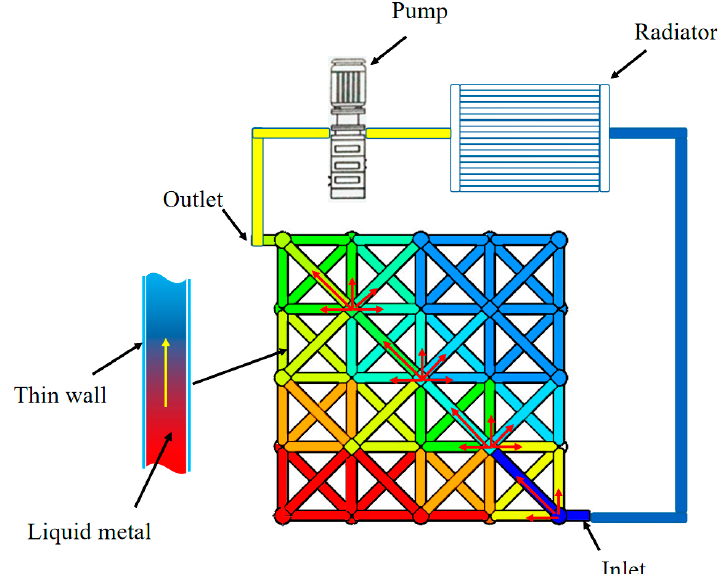
Figure 1. The design concept of the microlattice cooling system.